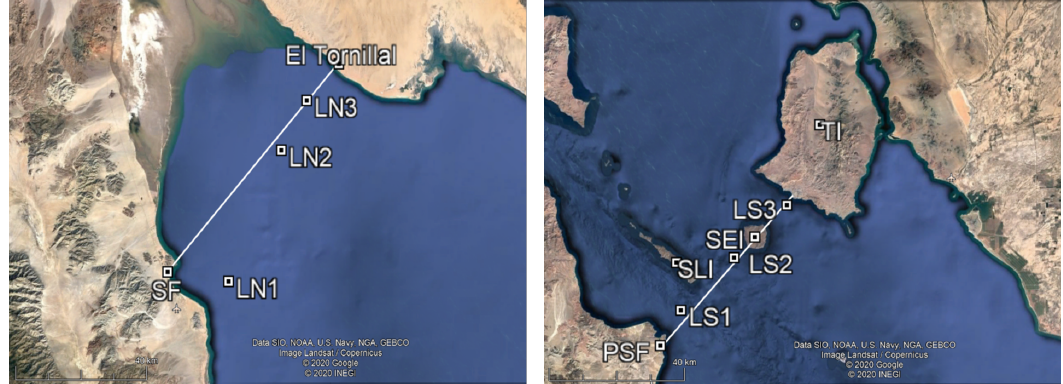
Figure 4. Northern ( left ) and southern ( right ) regions with largest tidal current speeds, with geographical markers for: San Felipe (SF), El Tornillal, Punta San Francisquito (PSF), San Lorenzo Island (SLI), San Esteban Island (SEI), and Tiburón Island (TI). The six locations with highest tidal current speeds are also